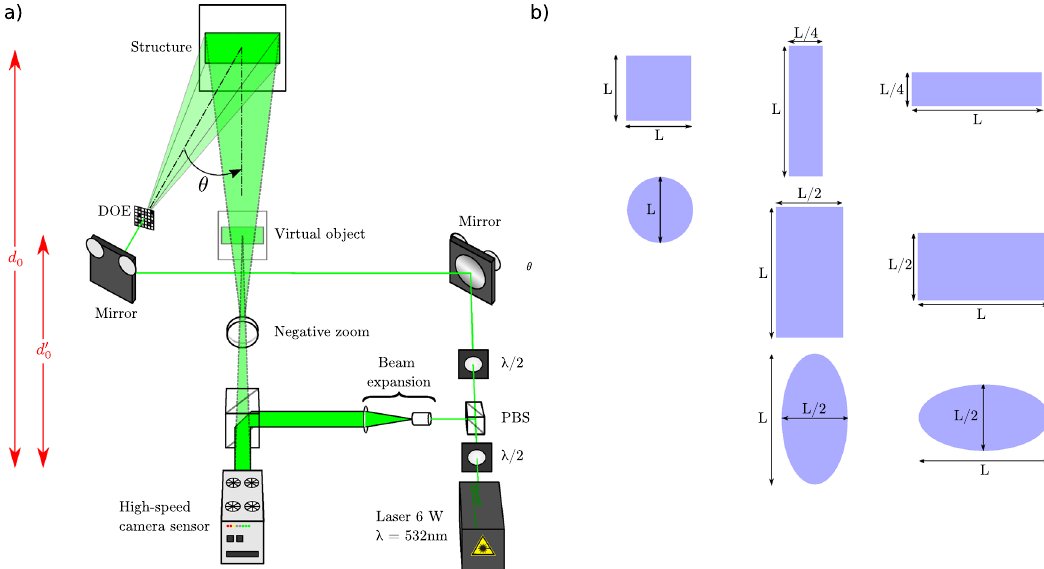
Figure 5. (a) Experimental set-up for wide-field holographic vibrometry (PBS: polarizing beam splitter, DOE: Diffractive Optical Element, (cid:31) / 2 half-wave plate), (b) set of beam shape structures that can be produced by the DOE to illuminate the object